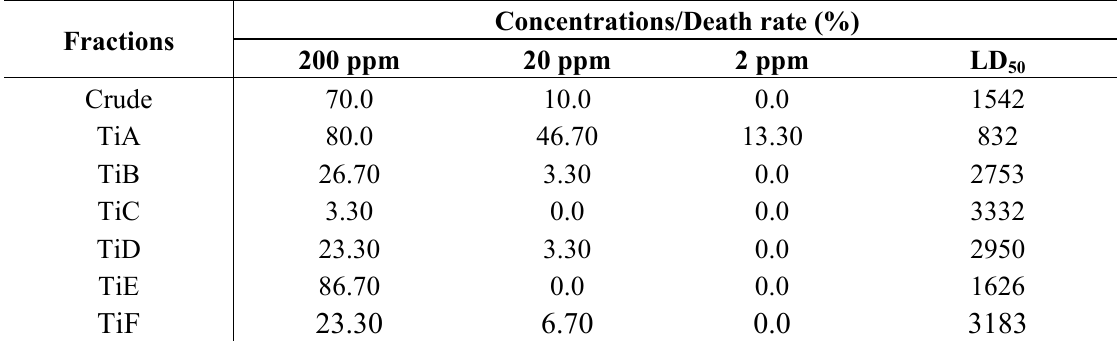
Table 21. Lethality of T. indica fractions on Brine